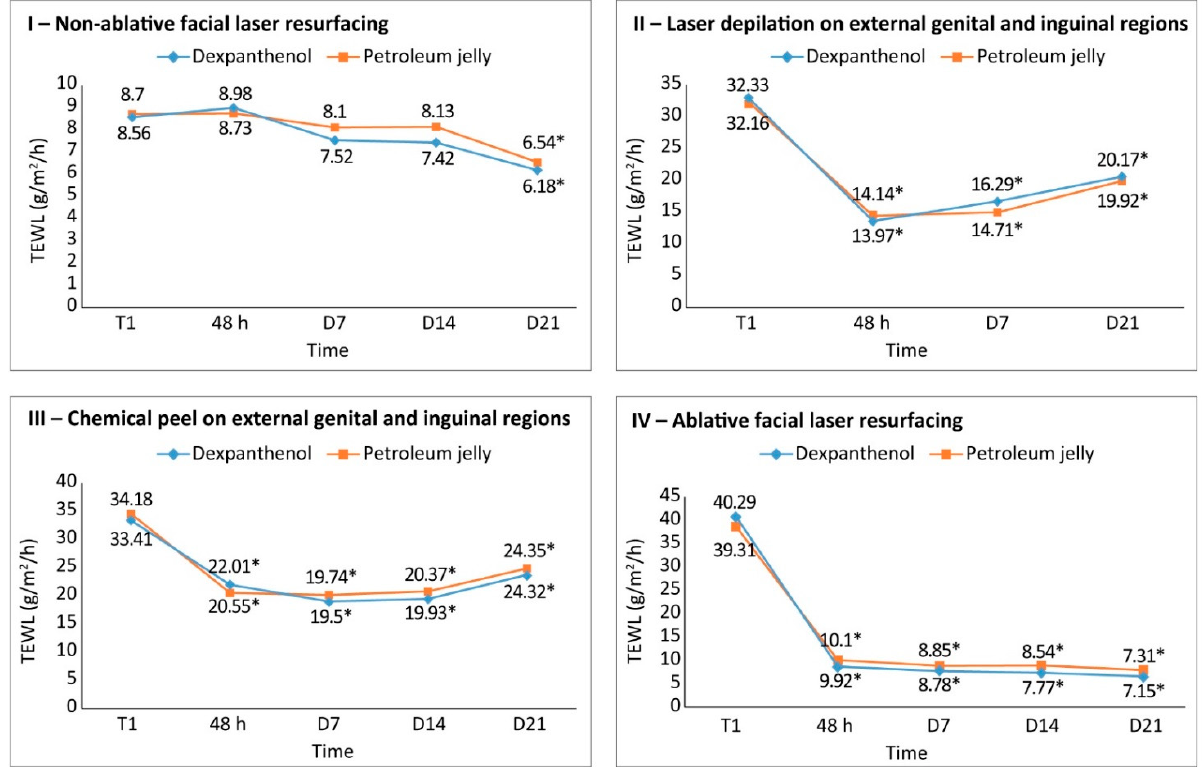
Figure 2. TEWL (g/m 2 /h) at time points after each procedure (ITT); * p < 0.05 vs. T1. There were no significant differences between Dexpanthenol-containing products and Petroleum jelly. T1: baseline at either 1 h after the procedure (studies 1 and 4) and immediately after the procedure (studies 2 and